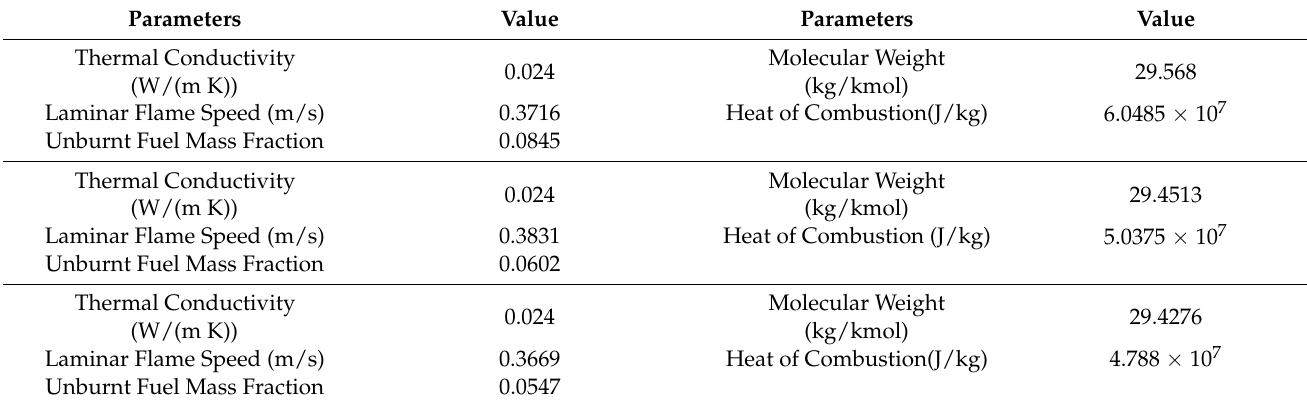
Table 1. Parameter